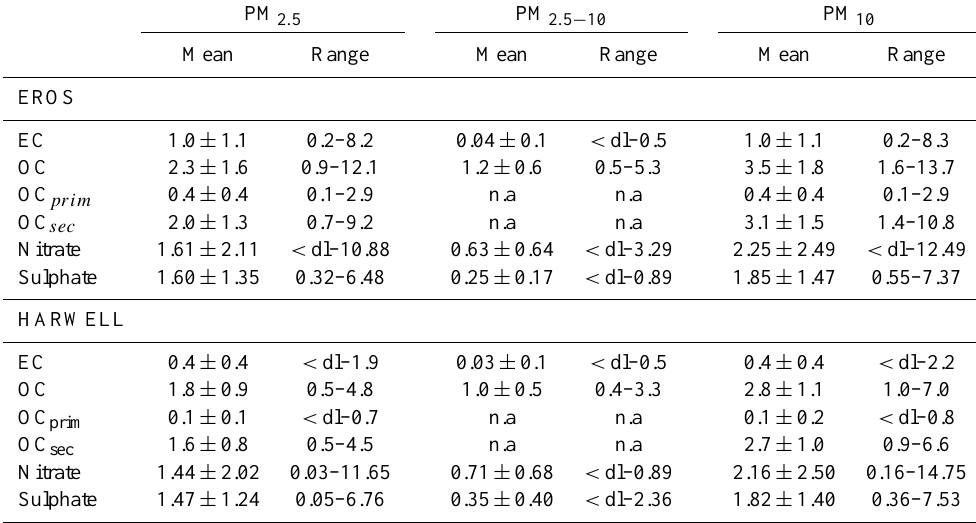
Table 3. Statistical data for EC, OC, OC prim and OC sec (µgm − 3 ) at EROS and Harwell sites collected simultaneously, (OC/EC) min =0.35; n =